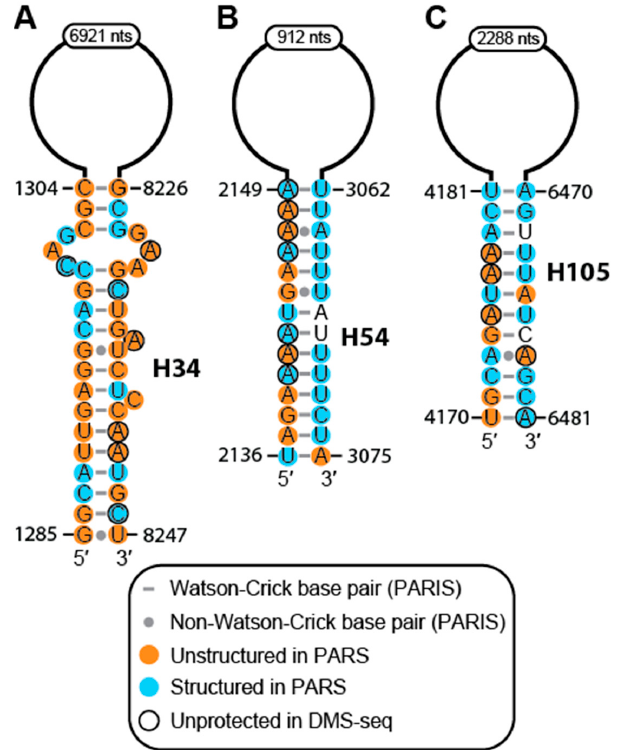
Figure 3. The secondary structural models for three long-range helices. The secondary structures are shown for PARIS-identified helices: ( A ) H34, ( B ) H54, and ( C ) H105 [21,22,26,27]. All PARS, DMS-seq, and PARIS data are annotated as described in Figure 2.